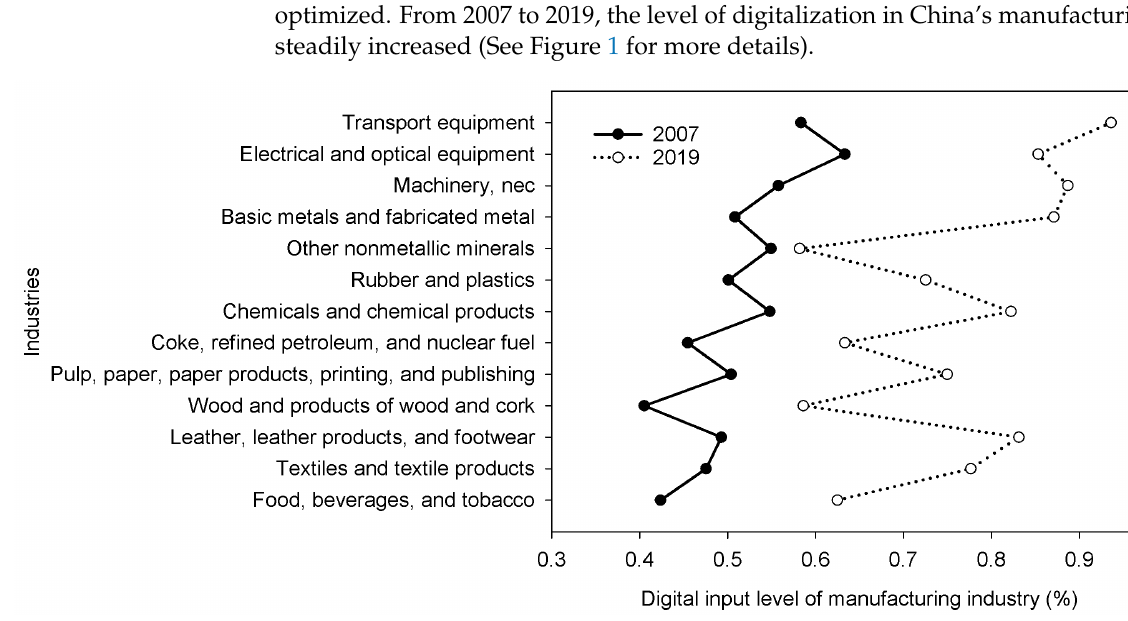
Figure 1. Digitalization level of China’s 13 manufacturing industries in 2007 and 2019 (%).